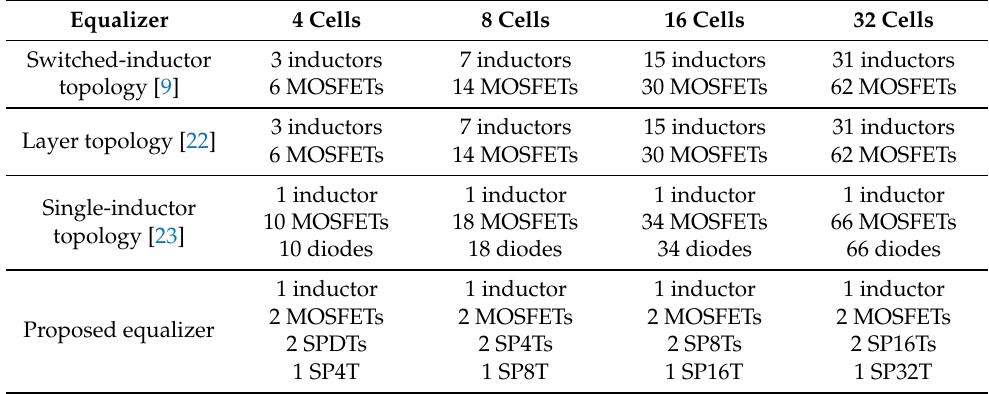
Table 3. Component count considering the number of cells in the battery